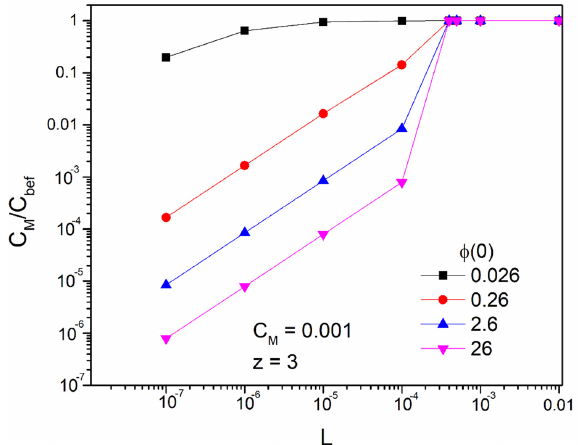
Figure 8. (cid:3004) (cid:3262) as a function of L (m) for z = 3, concentration 𝐶 (cid:3014) = 0.001 (cid:2923)(cid:2925)(cid:2922) (cid:3004) (cid:3277)(cid:3280)(cid:3281) φ (0)